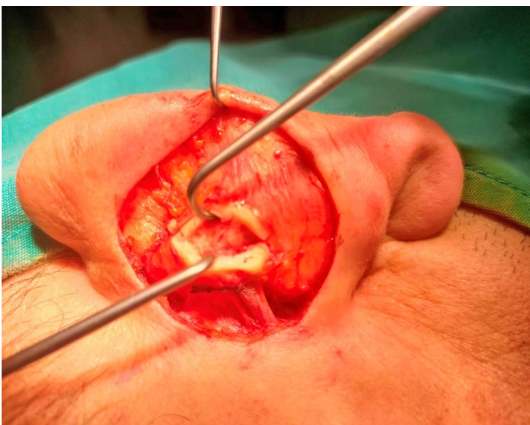
Figure 2. Excision of elliptical skin and conchal cartilage.